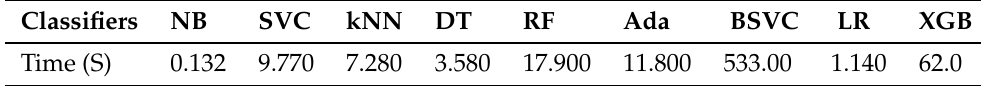
Table 7. Training and testing time of machine-learning algorithms.